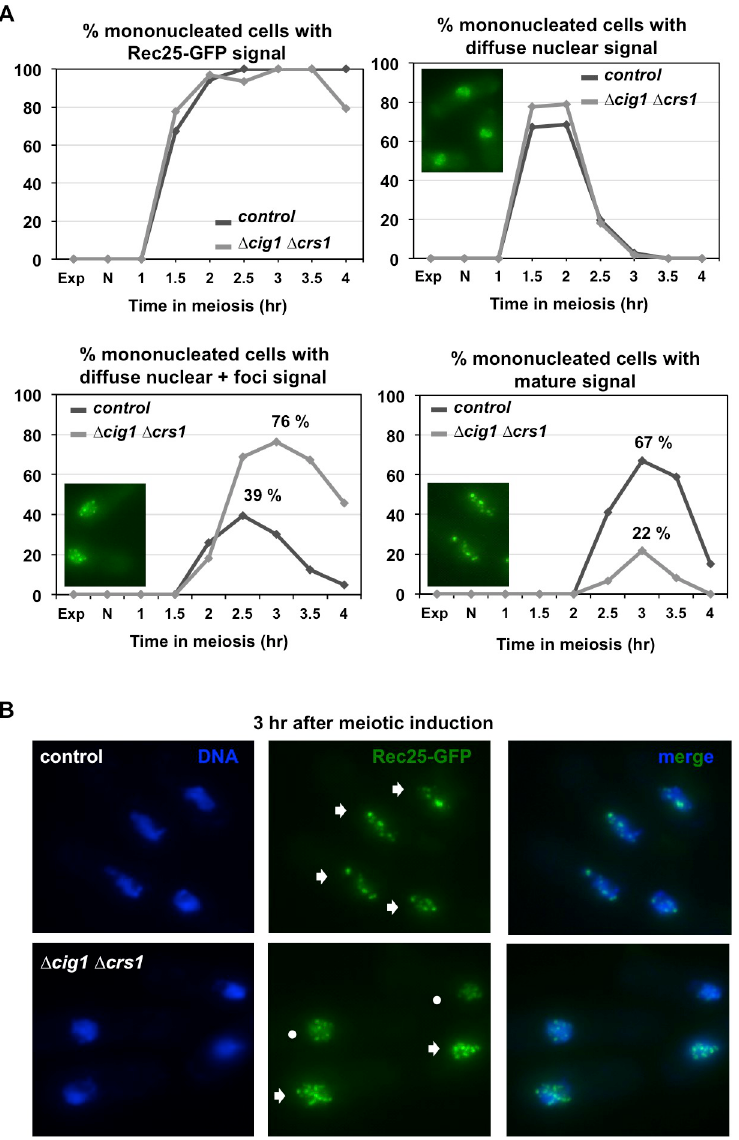
Fig 6. Defective LinE maturation in double cig1 crs1 deletion mutants. (A) Quantification of LinE formation by visualization of Rec25-GFP maturation status during synchronous diploid pat1-114 rec25-GFP meiosis of control (CMC78) and double cig1 crs1 deletion mutants (CMC1207). Graphs represent the percentage of mono-nucleated cells with Rec25-GFP signal (any category), diffuse nuclear signal (earliest transient category visible at S-phase), diffuse nuclear+foci signal (later transient category visible at prophase), and mature signal (clear foci; latest category visible at late prophase). An example of each category is shown in the inset picture in the corresponding graph. (B) Photographs of cells in prophase (Methanol/Acetone fixed) at 3 hr after meiotic induction when maximal maturation of LinEs is observed in the control. DNA (DAPI-staining; left panels), Rec25-GFP signal (middle panels), and both (merge; right panels). Circles indicate cells with Rec25-GFP diffuse nuclear+foci signal and arrows cells with mature signal. At least 45 cells were analyzed at each time point from 1.5 hr after meiotic induction (when signal first appeared), increasing the number of cells to 49–73 during